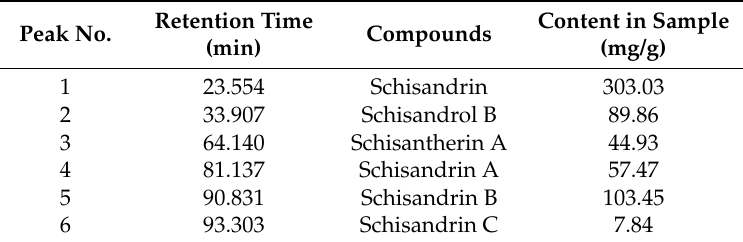
Figure 1. Characterization of SCL. High performance liquid chromatography chromatograms of the SCL and standards (Schisandrin, Schisandrol B, Schisantherin A, Schisandrin A, Schisandrin B and Schisandrin C) were detected at 220 nm. Table 1. The mean contents of each lignans.